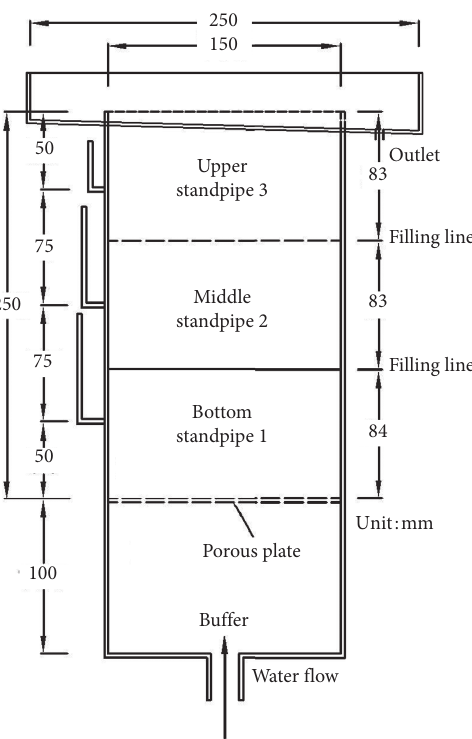
Figure 2: Schematic diagram of the cylindrical test tank. Table 2: Reynolds numbers for CFC and FC groups.